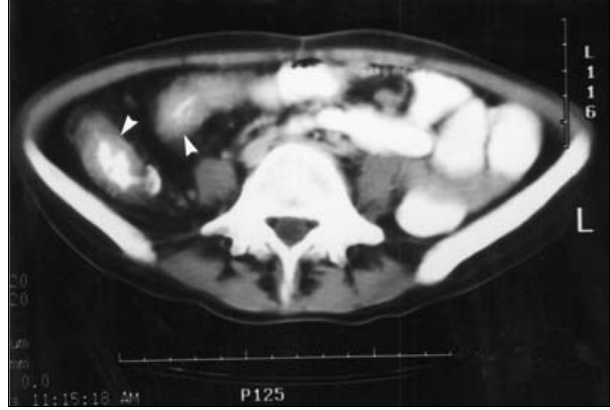
Figure 2) Computed tomography scan of the abdomen showing the ileocecal junction with a normal terminal ileum (small arrowhead) and thickening of the wall of the cecum (large